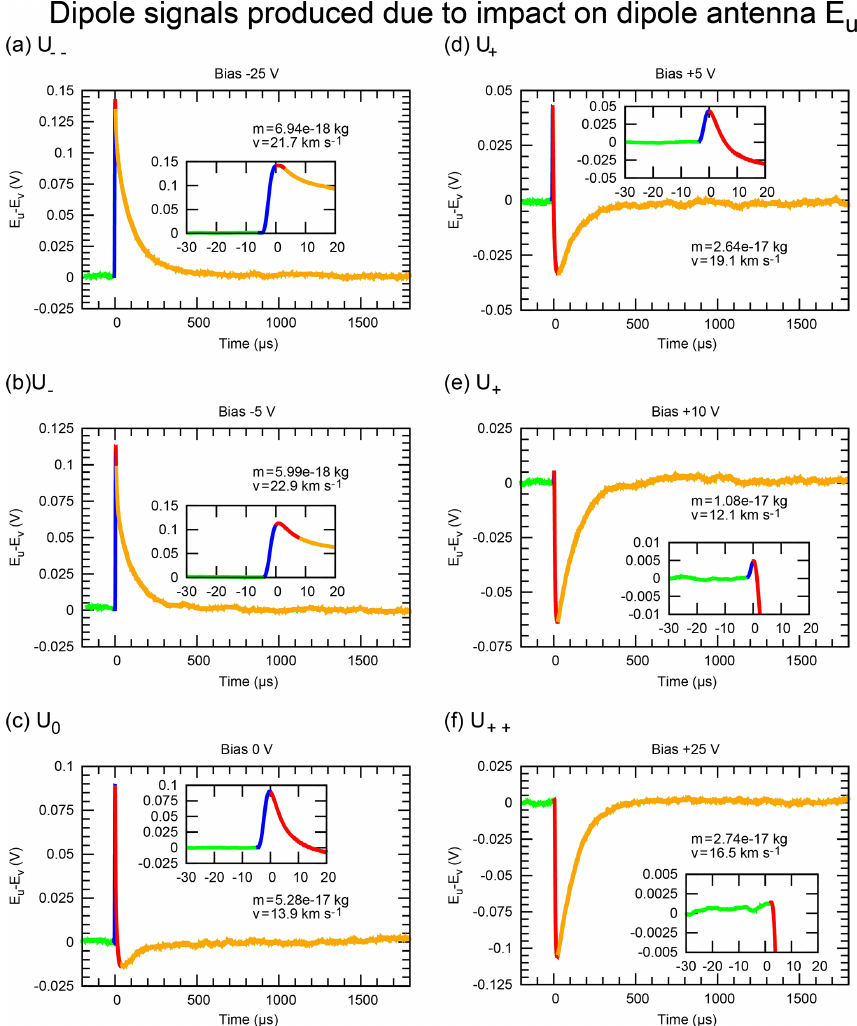
Figure 4. Laboratory simulation of dust impacts on the Cassini model showing the impact signal detected by the antenna ( E U boom was bombarded) for different polarities and sizes of bias voltage. Different phases of dust impact signal are distinguished by colours (green – cloud generation, blue – electron escape, red – ion escape, orange – relaxation). The inserts show details of the pre-spikes (modified from Nouzák et al., 2018). The conditions in these laboratory measurements are comparable to a measurement in monopole configuration on the spacecraft.